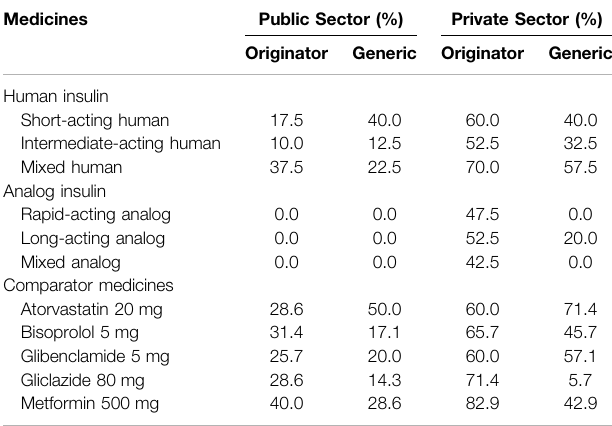
TABLE 3 | Mean availability (%) of insulin and comparator medicines in government- and private-sector hospital pharmacies.